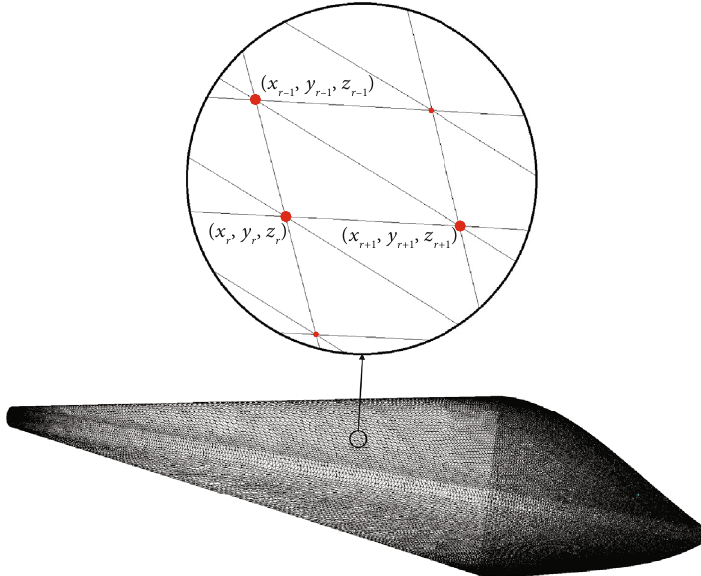
Figure 3: The representation points of the fi eld metamodel.